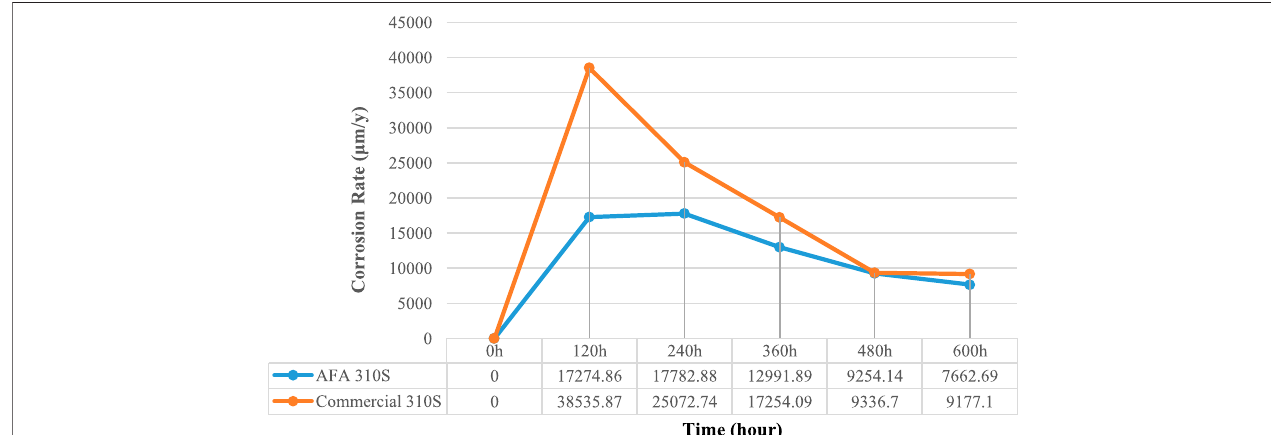
FIGURE 2 | Corrosion rates versus time for two alloys in molten chloride salt at 800 ° C in air.